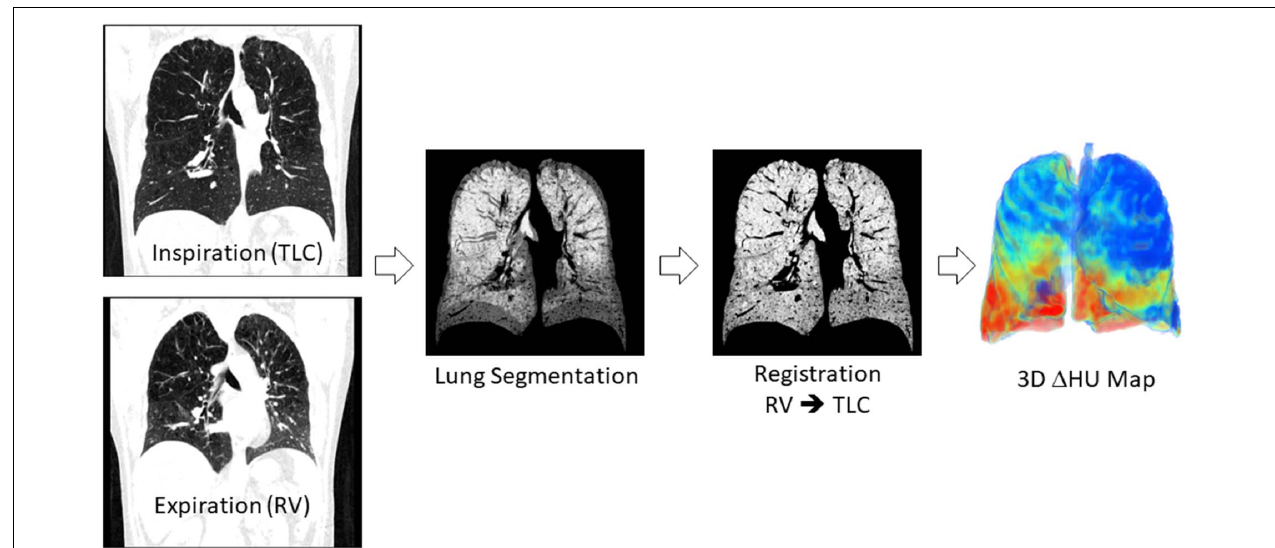
FIGURE 1 | Image processing workflow. Inspiratory and expiratory CT images were segmented using a region growing algorithm. The segmented expiratory image is warped using elastic image registration software to match the inspiratory image. The indices of regional lung ventilation are computed based on the registered and inspiratory images.